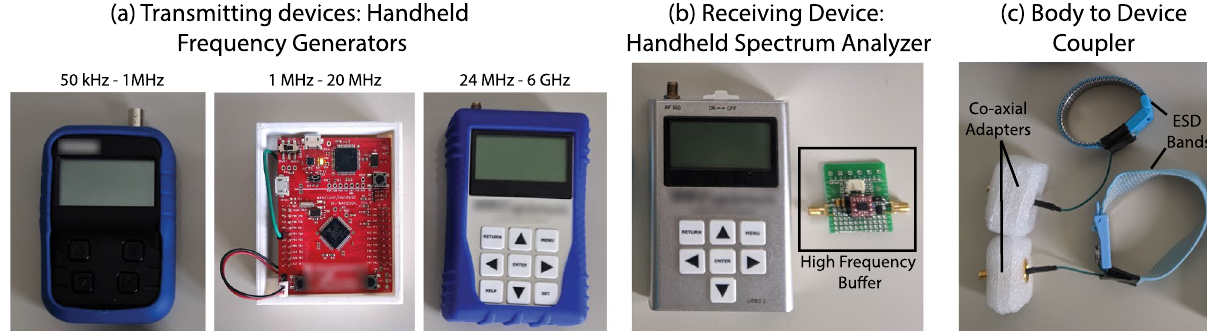
Figure 9. Devices used for experiments: ( a ) Transmitting devices: Velleman Handheld RF Generator for freq < 1MHz , signal generator built using a Tiva C Launchpad Board for freq 1MHz–20MHz and RF Explorer Handheld RF generator for freq > 24 MHz . ( b ) RF Explorer Handheld spectrum analyzer used as a receiving device, and a high-frequency buffer used for high impedance/capacitive load measurements. ( c ) Couplers used to connect the transmitter and receiver devices to